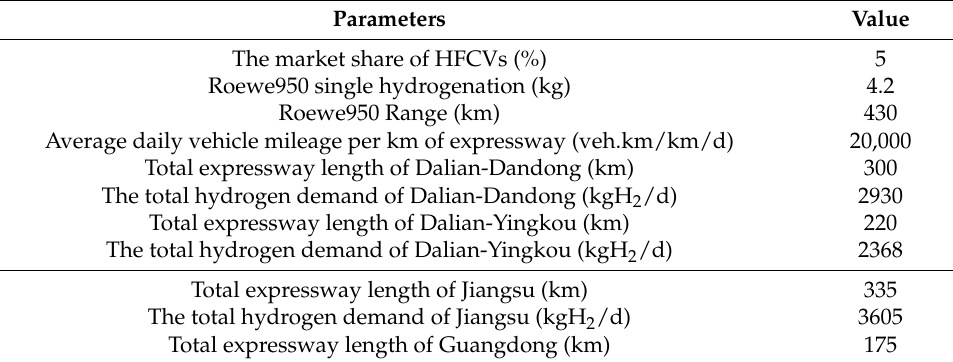
Table 6. Relevant parameters of hydrogen demand for expressways.